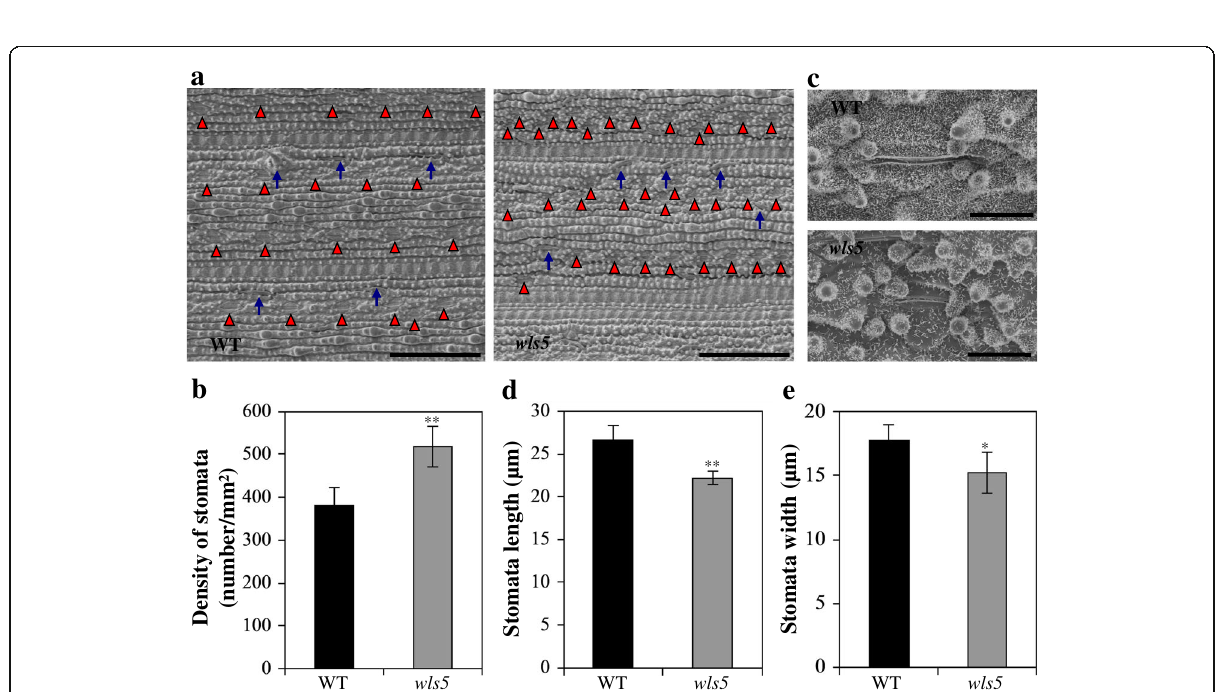
Fig. 6 Observation of stomata in wild-type (WT) and wls5 plants. a Stomatal density of WT ( ‘ 93 – 11 ’ ) and wls5 leaves at tillering stage. Red triangles and blue arrows indicate the positions of stomata and setae, respectively. Bars = 100 μ m. b Statistical analysis of stomatal density. c Morphological characteristics of stomata of WT and wls5 plants at tillering stage. Bars = 10 μ m. d , e Statistical analysis of stomata length ( d ) and stomata width ( e ). Three independent replicates for stomatal density, and 20 independent replicates for stomata size. ** P < 0.01 (Student ’ s t -test)